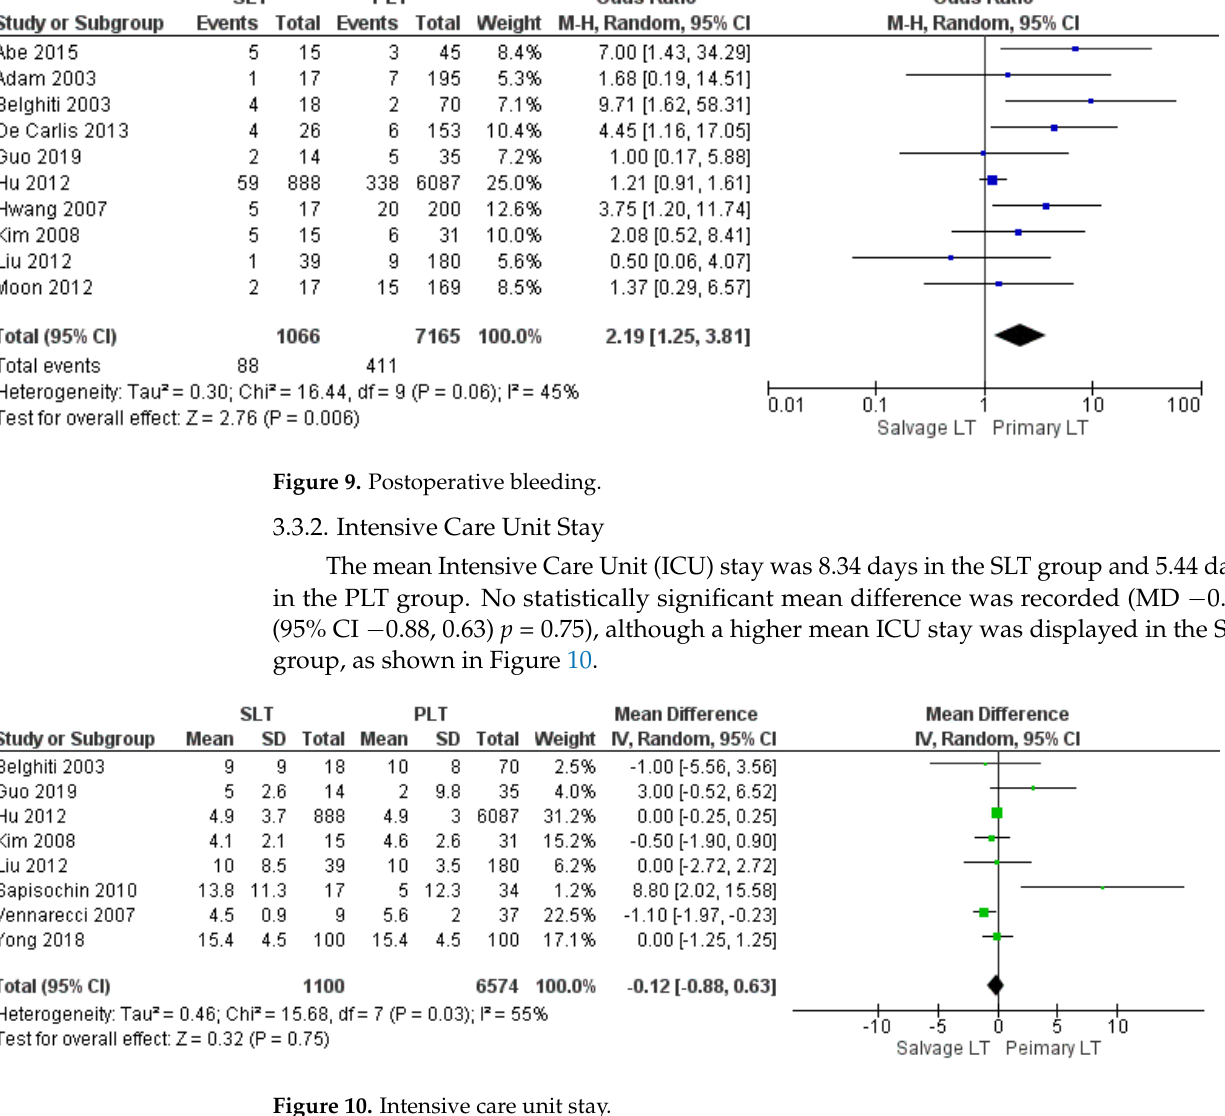
Figure 10. Intensive care unit stay.